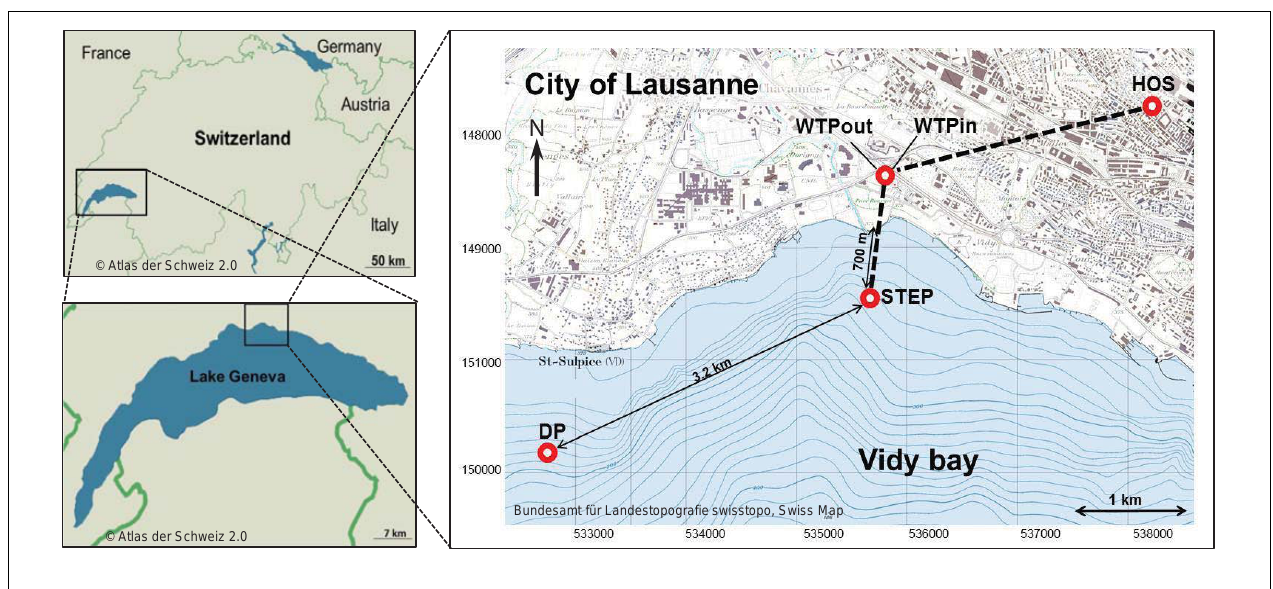
FIGURE 1 | Map of the study area and sampling sites. Effluents of Lausanne’s wastewater treatment plant (WTP) are discharged via pipe 700m off shore at 30m depth (STEP, Station d’épuration, Swiss coordinates: